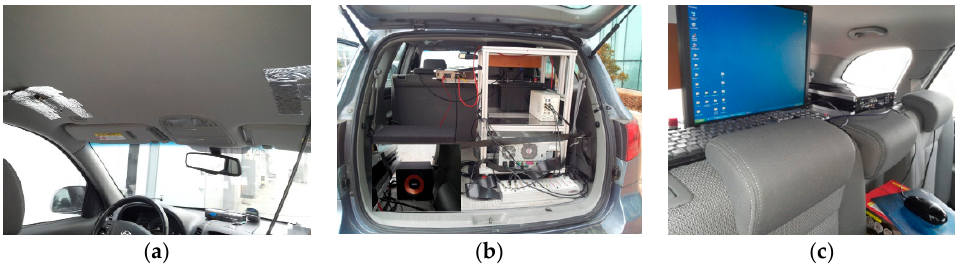
Figure 12. Test car for the active control of interior noise ( a ) error microphone; ( b ) the secondary speaker and controller ( c ) controller monitor.